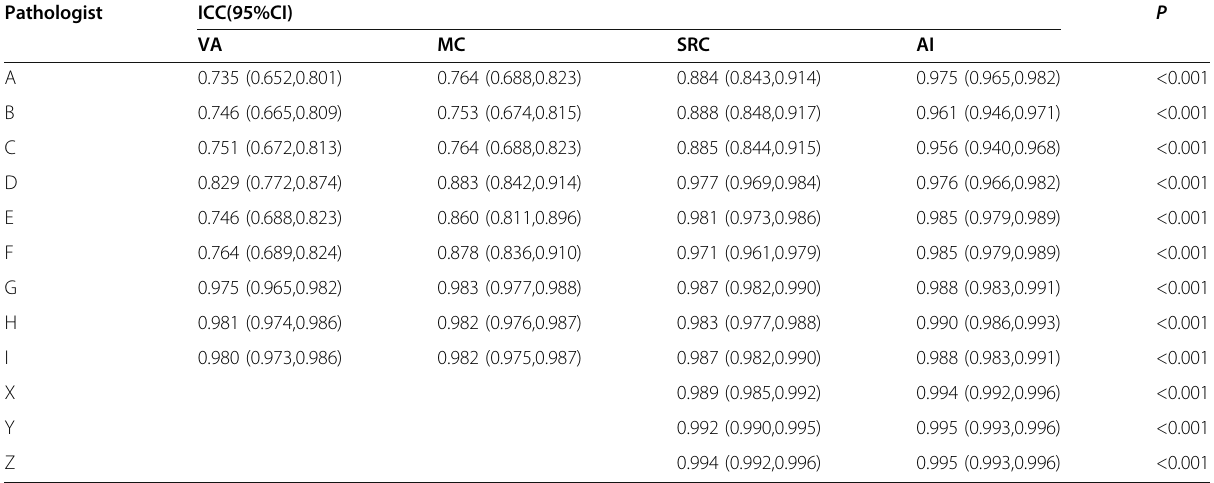
Table 2 Consistency between the results of nine pathologists ’ interpretation of Ki-67LI using VA, MC, SRC and AI and the gold standard